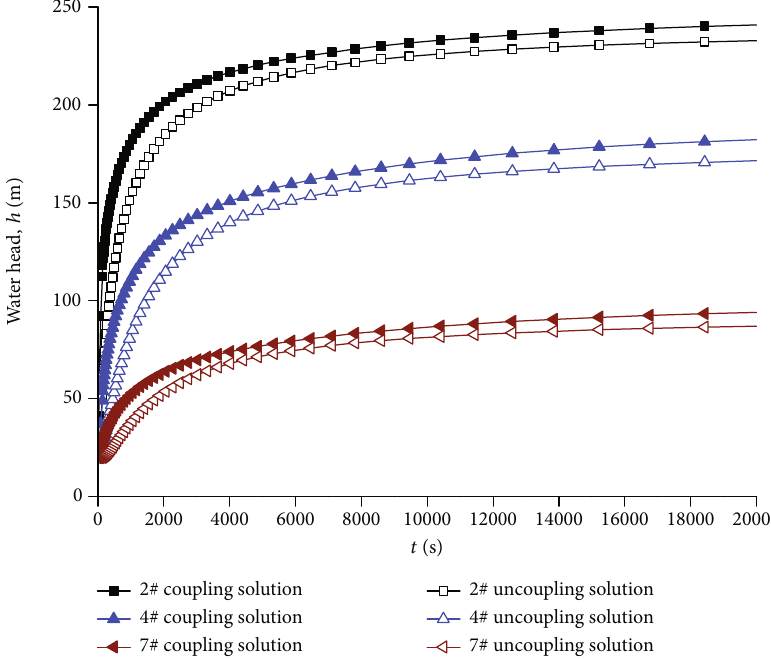
Figure 5: Water head evolution at the nodes 2#, 4#, and 7# in the fi ssure